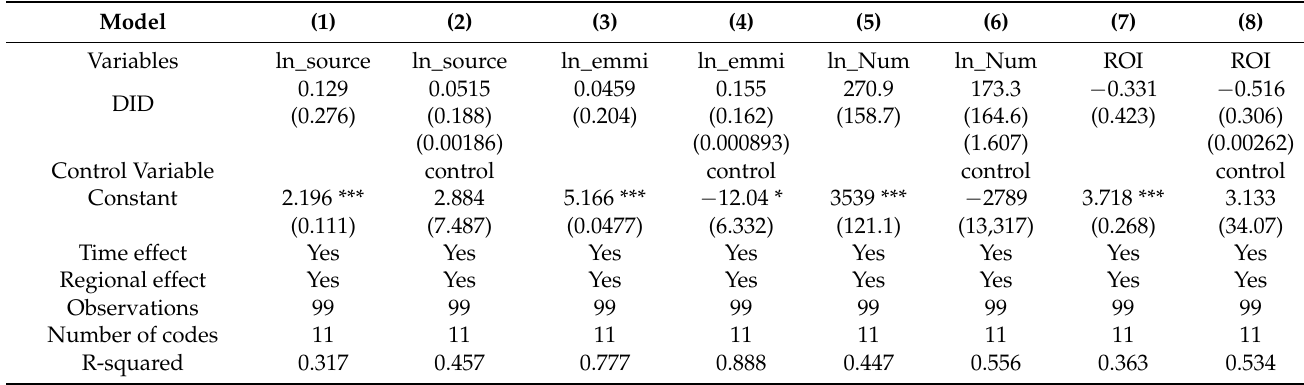
Table 7. Placebo test results 1